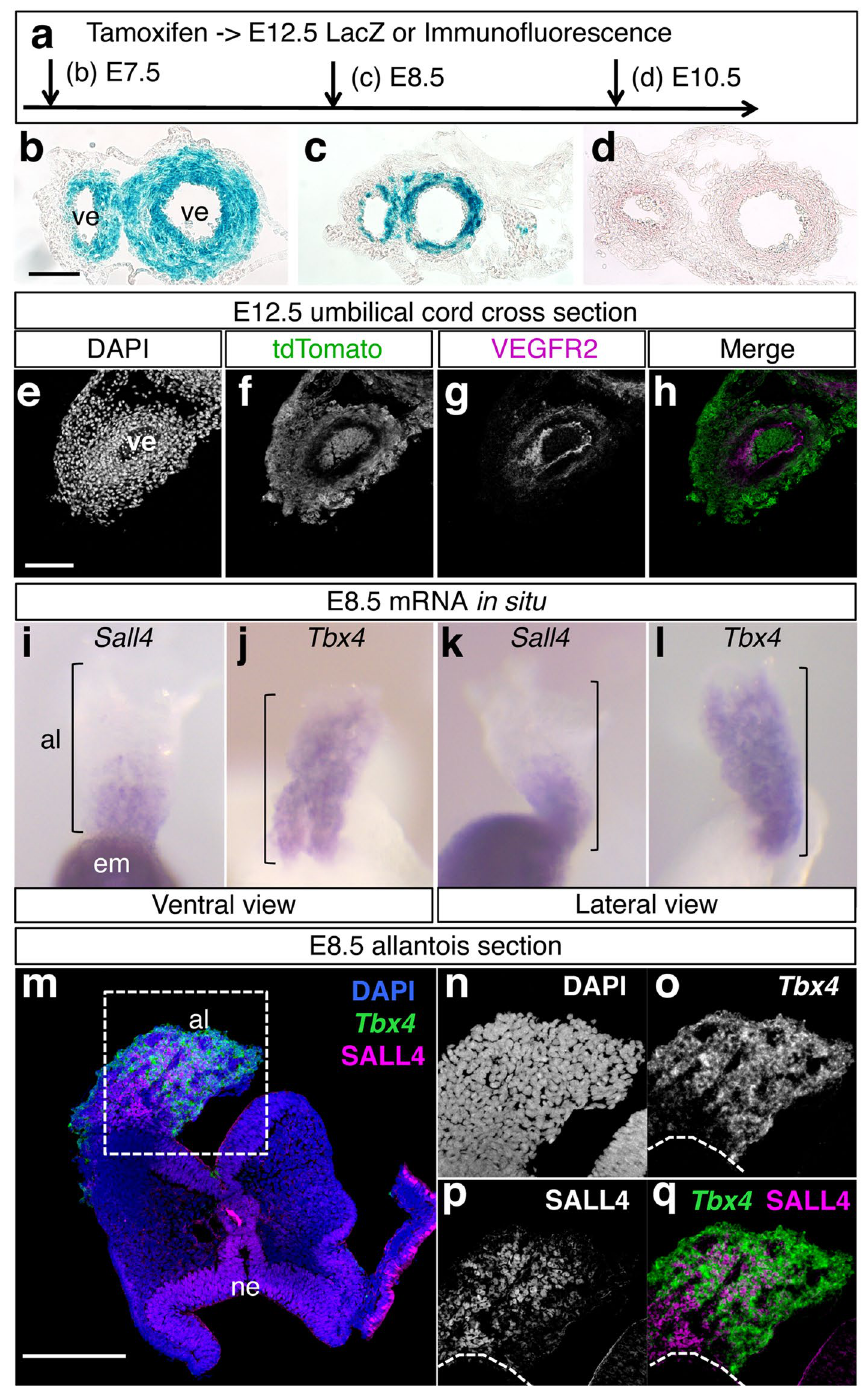
Figure 6. Sall4 lineage contribution to peri-vascular mesenchyme in the umbilical cord. Schematic of tamoxifen injections at different time points of embryonic development. ( b – d ) Cross section of LacZ-stained umbilical cord. Scale bar in panel b: 100 µ m. Panels b to d are in the same scale. ( e – h ) Immunofluorescence images of DAPI ( e ), tdTomato ( f ), VEGFR2 ( g ) and merged image ( h ). The tdTomato signals do not overlap with VEGFR2. Scale bar in panel e: 100 µ m. Panels e to h are in the same scale. ( i – l ) Whole mount in situ hybridization of Sall4 ( i , k ) and Tbx4 ( j , l ) of E8.5 embryos. Ventral views ( i , j ) and lateral views ( k , l ) of the allantois are shown. ( m – q ) Double detection of SALL4 immunoreactivities (magenta) and Tbx4 mRNA (green) on allantois sections. Panels n–q show closeup of the dotted square in ( m ). Panels n, o and p are shown in a black/white mode. Dotted lines in ( o – q ) indicate the border between the allantois and the embryo. Scale bar in m: 200 µ m. Abbreviation. al: allantois, em: embryo, ne: neuroectoderm of the head region, ve: